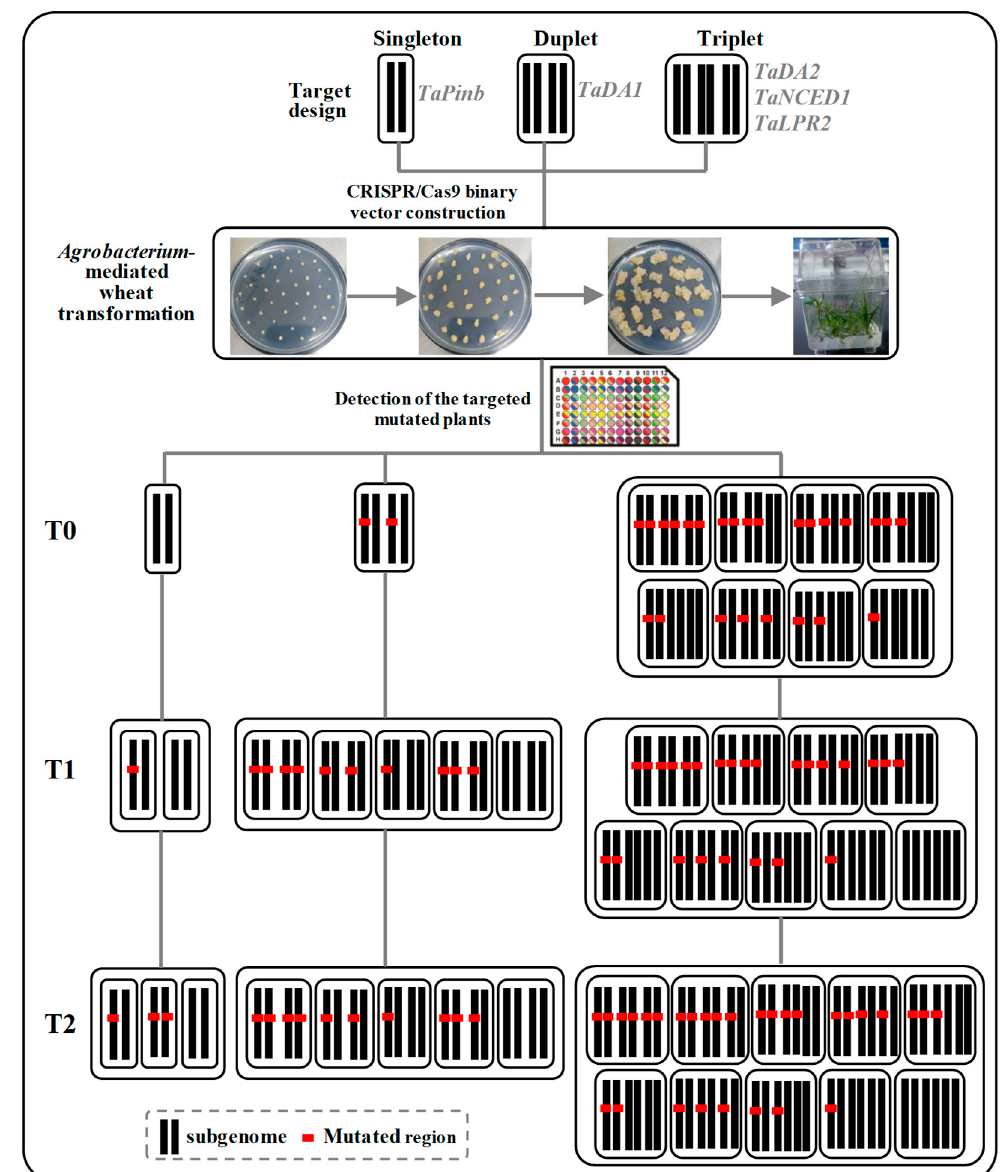
Figure 7. Schematic overview of the procedure for the generation of mutations and mutation detection in T0, T1 and T2 wheat plants. We targeted five genes in wheat using the CIRSPR / Cas9 system with Agrobacterium-mediated delivery. The transgenic wheat plants were then evaluated with the Hi-TOM mutation detection kit. A high mutation e ffi ciency could be obtained in T0 plants, and the mutations could be stably transmitted to the T1 and T2 progenies.